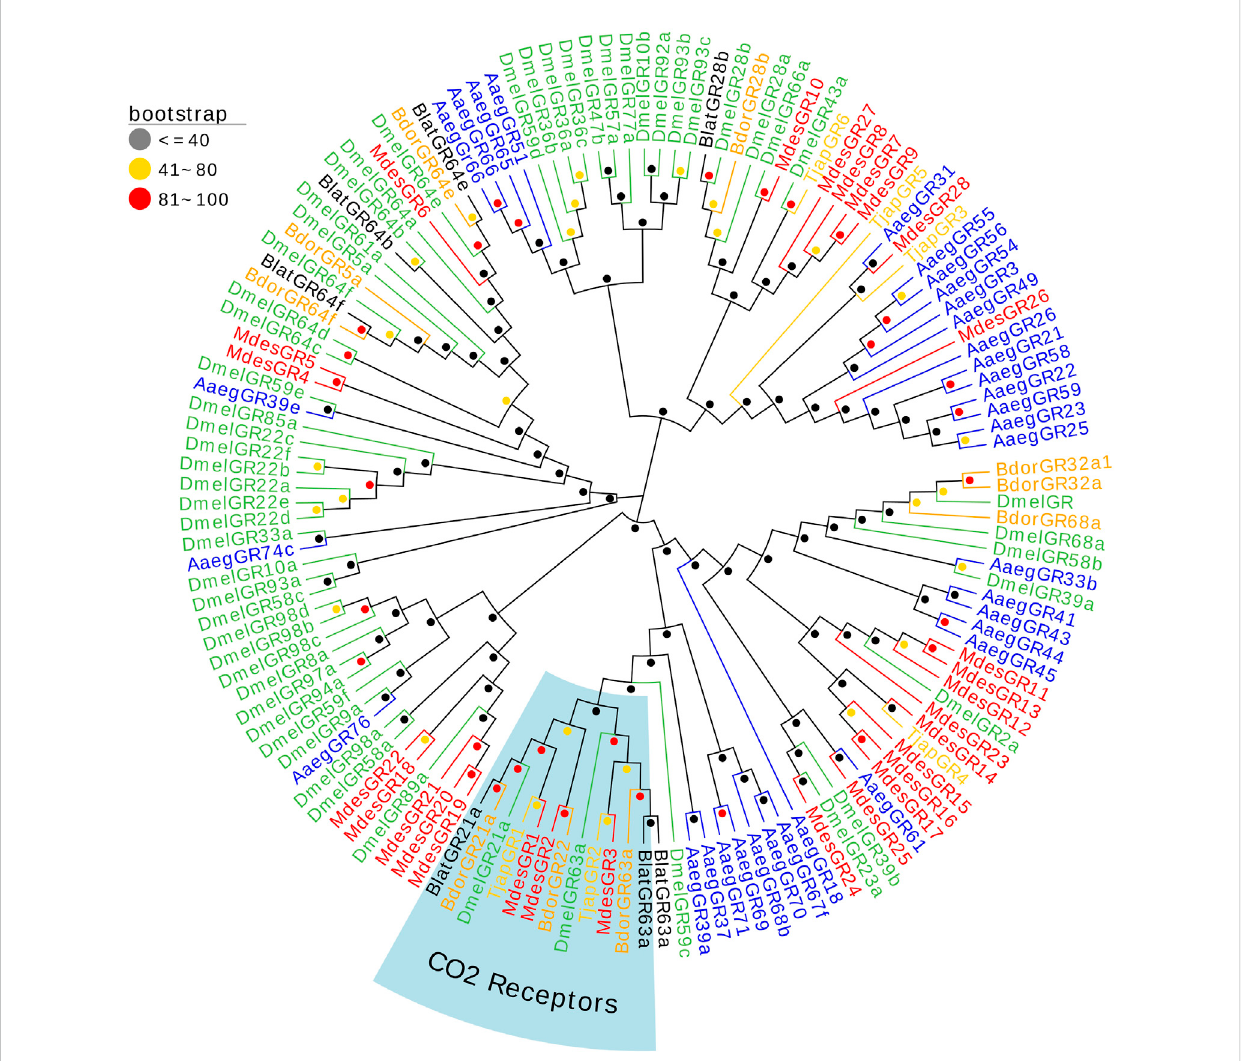
FIGURE 4 The NJ phylogenetic analysis of GRs in T. japonensis , B. dorsalis , A. aegypti , M. de-structor , B. latifrons , and D. melanogaster . The CO 2 receptors group is shown.